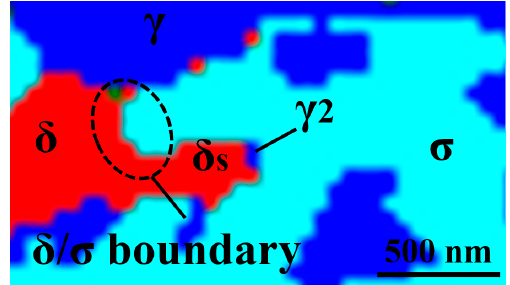
Figure 6. High-magnification EBSD phase map for 640 °C, suggesting that the δ / σ boundary had already passed when γ 2 started forming. Table 3. Chemical composition of σ formed at different aging temperatures.